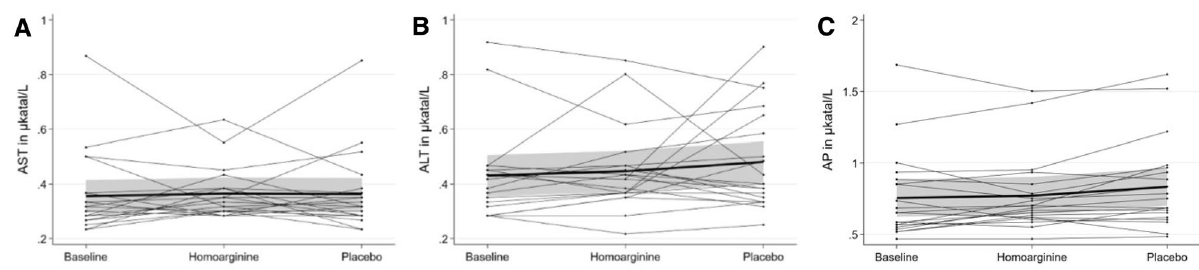
Figure 2. Individual time course of ALT ( A ), AST ( B ) and AP ( C ) levels over the difference phases of the cross- over trial. The thick lines represent the mean time